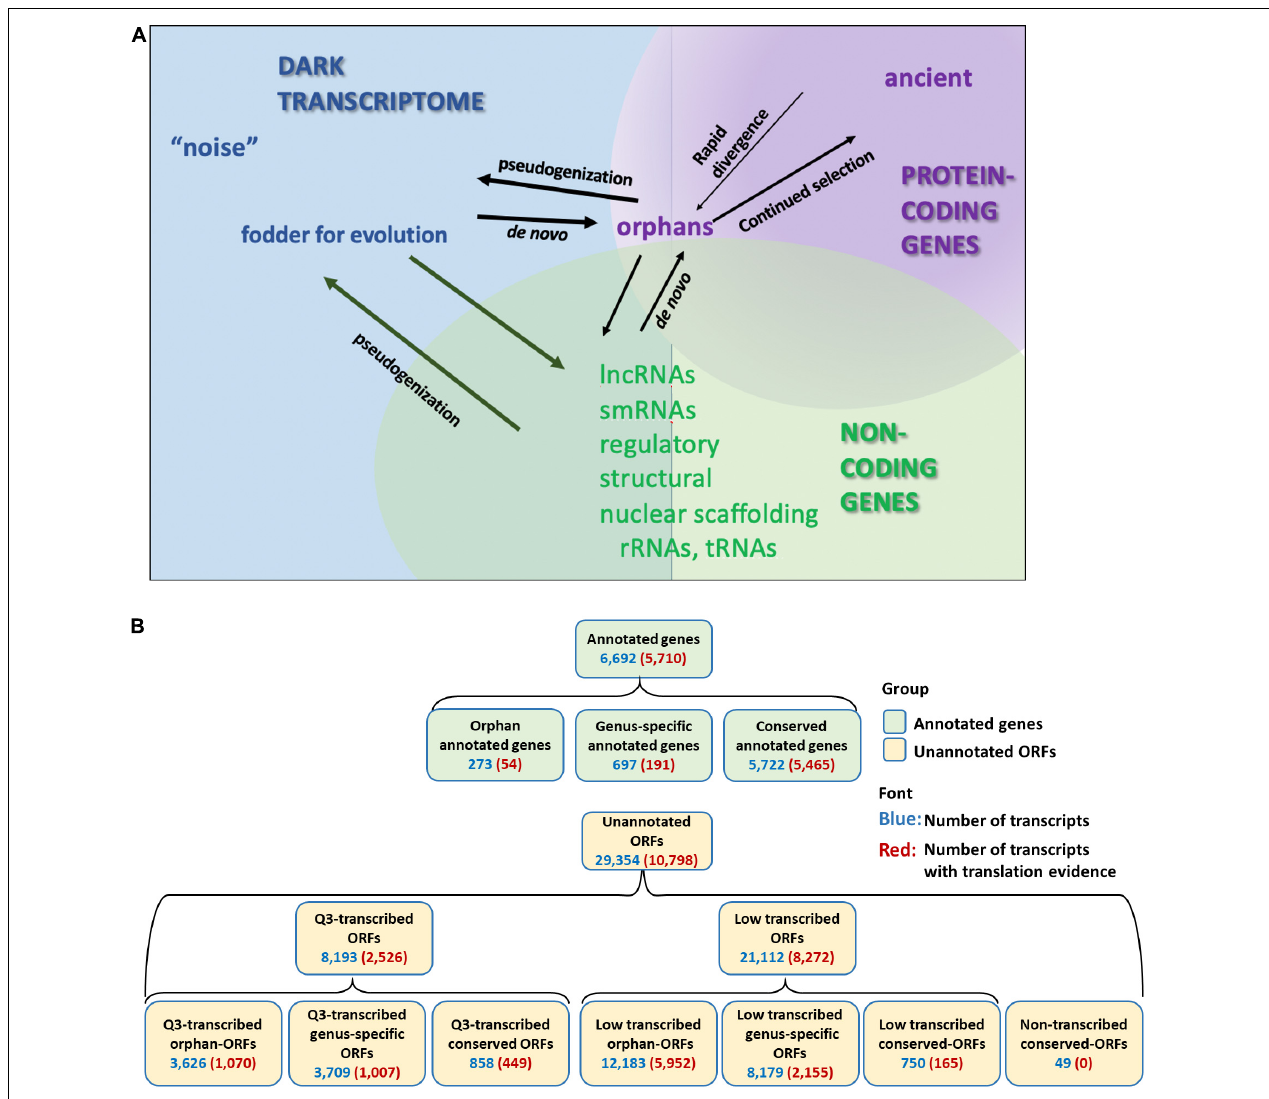
FIGURE 1 | Annotated genes and dark transcriptome. (A) Definition of Dark transcriptome. Pervasive transcription of unannotated sequences has been found in many species. Some of these might be protein coding genes that have escaped annotation. Most of these unannotated coding genes are orphan (species-specific) genes, which have no homolog to other species, and are hard to predict using current gene prediction tools. These orphan genes could emerge by rapid divergence from ancient genes or could evolve de novo . Other transcribed but unannotated sequences might be non-coding genes. Although many studies have explored the function and classification of the non-coding transcripts, many transcribed sequences are still unclassified. (B) Classification and numbers of transcripts with transcription or translation evidence for annotated genes and open reading frames (ORFs). Orphan-ORFs, protein is unique to Saccharomyces